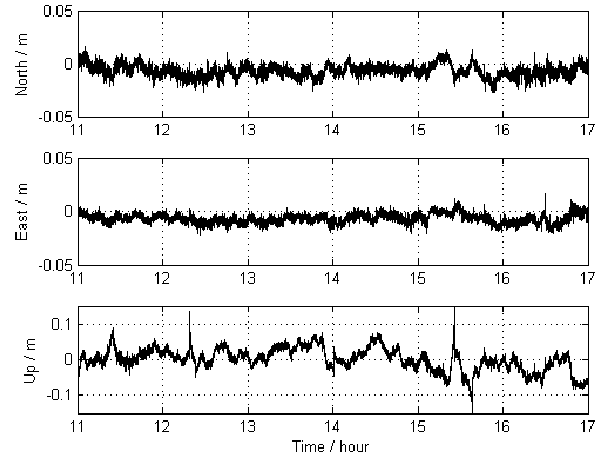
Figure 8. Differences between the KIN1 positioning results obtained from Scheme 3 (far-away-located reference stations and distance constraints) and those of Scheme 1.